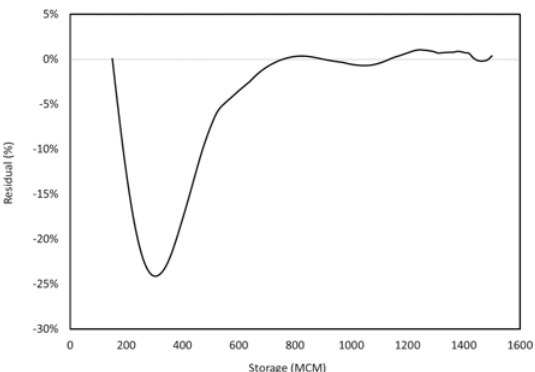
Fig 4. The residuals variation over the entire interpolation interval of the state variable for the Chebychev approximation